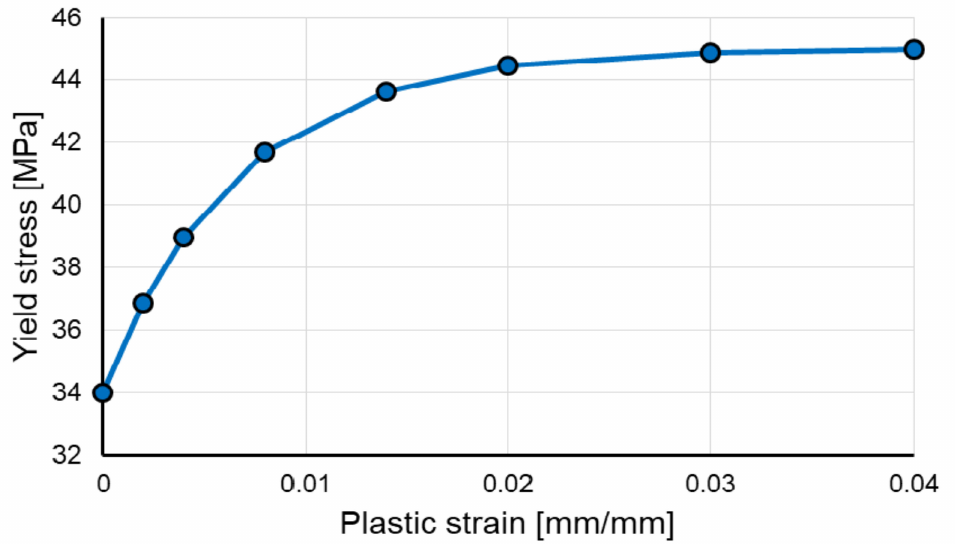
Figure 8. Multi-linear hardening